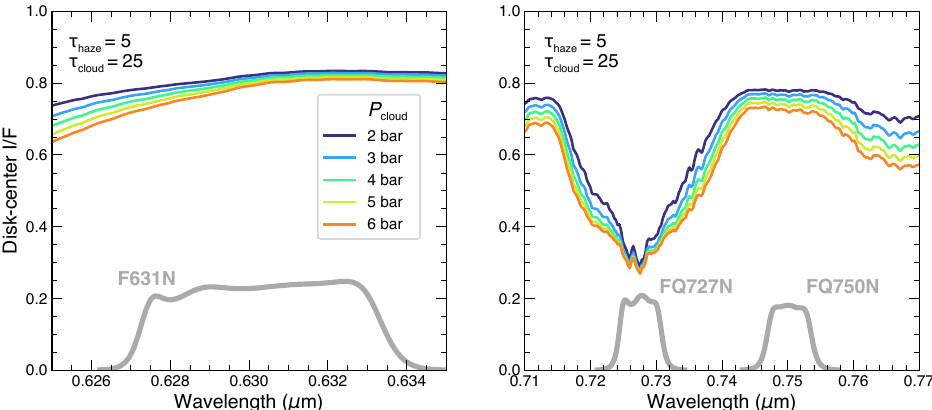
Figure 13. Model spectra across the bandpasses of the continuum (631 and 750 nm) and weak methane band (727 nm) filters illustrate the sensitivity to deep cloud level for a fixed upper and lower opacities ( τ haze = 5 and τ cloud = 25). The 631-nm filter has good continuum response (no sensitivity to deep cloud level) over most of the bandpass, with some pressure-sensitivity in the blue end due to proximity to the weak methane band at 619 nm. The 727-nm bandpass is almost insensitive to deep cloud in the core of the band, but the edges of the filter bandpass give sensitivity to deep cloud pressure level. The 750-nm filter has some sensitivity to deep cloud level, presumably due to NH 3 absorption within the bandpass, but the fractional change in I / F is lower than for 727 nm, so the CM7 ratio (with 750 nm as the continuum wavlength) still serves as an indicator of cloud depth. Finally, the bottom row of Figure 12 provides the best match to the maximum I / F center-to-limb curve for the three filters, with τ haze = 10 and τ cloud = 100. Despite the high upper cloud/haze opacity, some sensitivity to p cloud remains due to the very high value of τ cloud = 100 required to match the maximum reflectivities. Better fits are found for p cloud = 2 bar than for deep clouds at higher pressures, so it is possible that a model with more freedom might prefer clouds within the 1–2 bar region. However, we did not test this type of cloud structure because cloud condensation efficiency is reduced at this level, according to theoretical arguments discussed in Section